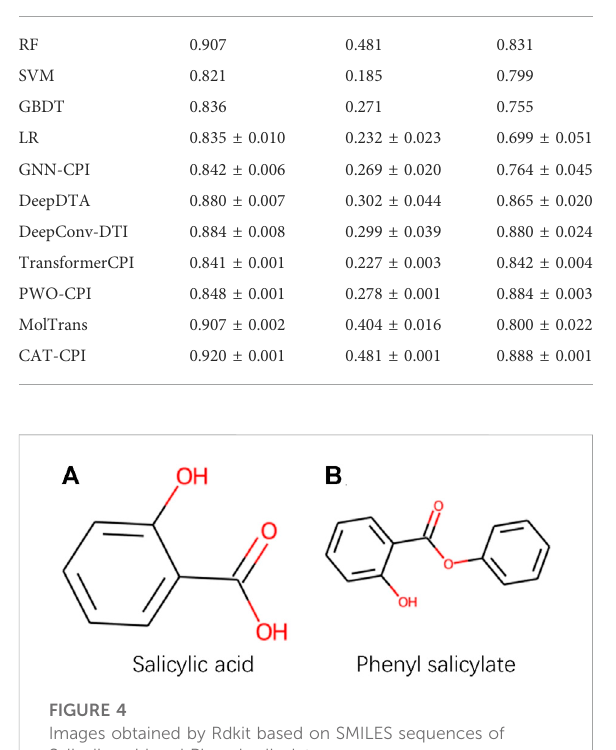
molecule is learned based on the semantic relationship of its context. As shown in Figure 4 and Tables 2, 3 the results on the three datasets demonstrate that CAT-CPI is quite robust.